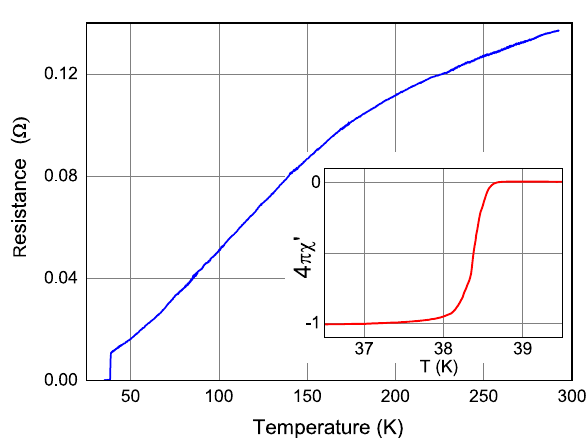
Figure 2. Temperature dependence of the longitudinal resistance R ab of the Ba 0.6 K 0.4 (FeAs) 2 single crystal in the temperature range ( 4.2 ÷ 280 ) K . The inset shows the temperature dependence of the magnetic susceptibility of this sample under cooling in zero magnetic field. R ( 300K )/ R ( 40 K ) = 12 , T c = 38.5K , � T c ( 10% ÷ 90% ) = 0.3K as determined from the magnetic